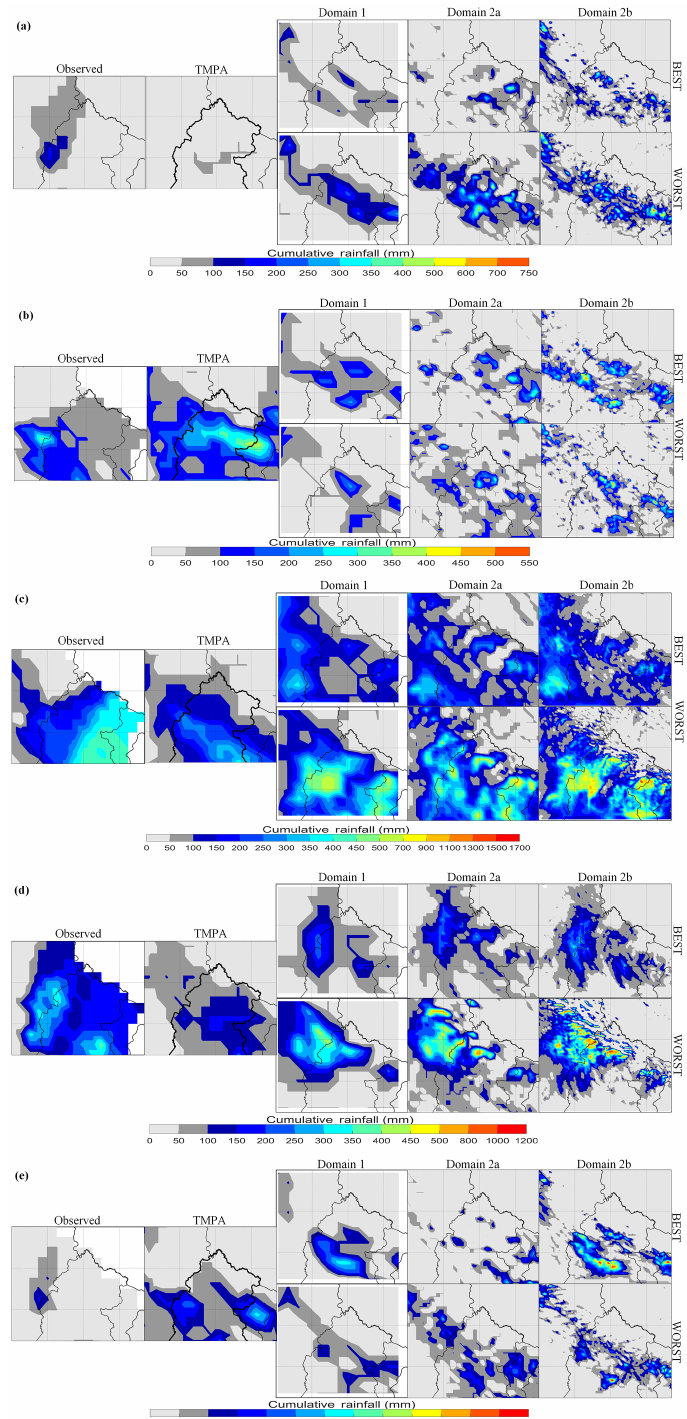
Figure C1. Spatial plots presenting the rainfall simulations obtained across the three domains for the best and the worst configuration for heavy to extremely heavy rainfall events during (a) Event 1 (18–22 June 2008), (b) Event 2 (29 July–2 August 2010), (c) Event 3 (15– 19 August 2011), (d) Event 4 (17–21 September 2010) and (e) Event 5 (11–15 September